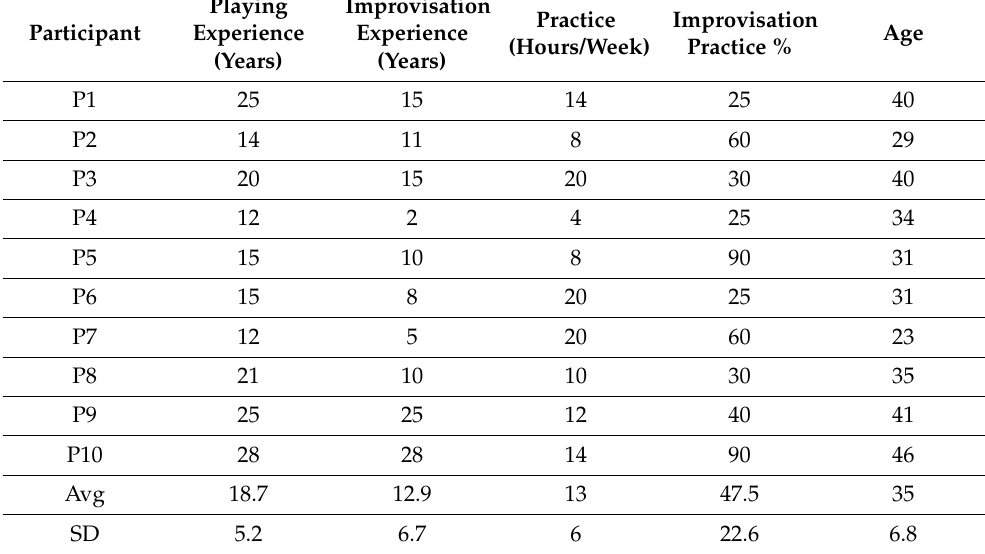
Table 1. Participants’ drum playing experience (years), improvisation experience (years), practice (hours/week), improvisation (% of the practice), and